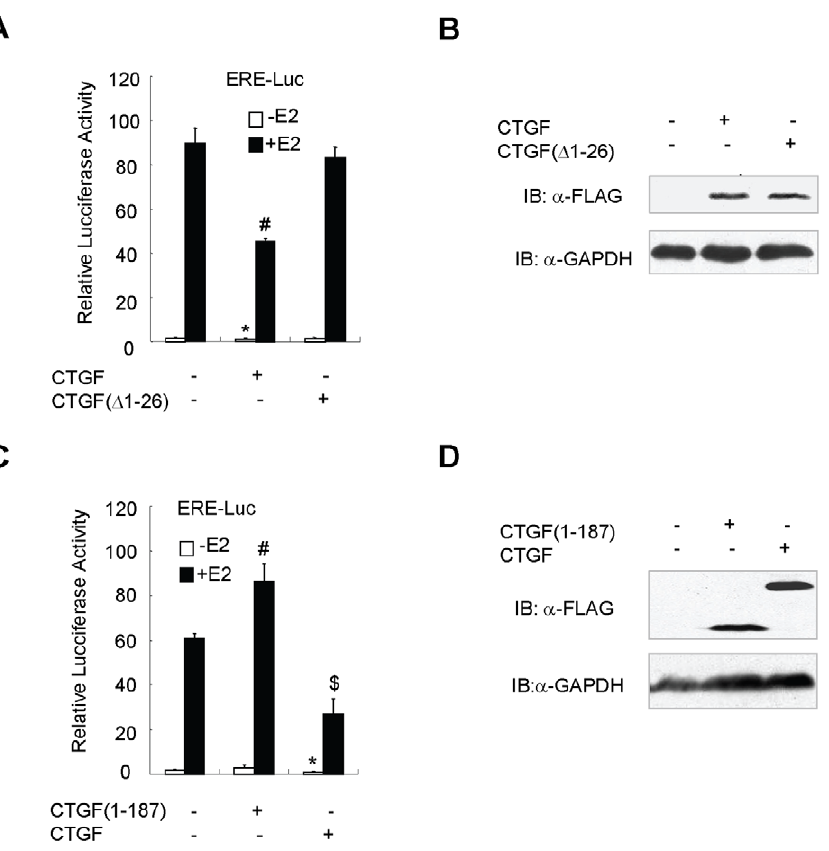
Figure 6. Effects of CTGF deletion mutants on estrogen-responsive reporter activity. (A) Luciferase reporter assay with the CTGF deletion mutant without the signal peptide. ZR75-1 cells were cotransfected with ERE-Luc and FLAG-tagged CTGF or CTGF( D 1-26) as indicated. Cells were treated and analyzed as in Fig. 4A. * P , 0.01 versus empty vector without E2. # P , 0.01 versus empty vector with E2. (B) Western blotting showing expression levels of FLAG-tagged CTGF and CTGF( D 1-26) with antibody against FLAG or GAPDH. Cells were transfected in the presence of E2 as in (A). (C) Luciferase reporter assay with the CTGF deletion mutant lacking ER-binding site. Cells were cotransfected with ERE-Luc and FLAG-tagged CTGF or CTGF(1–187) as indicated. * P , 0.01 versus empty vector without E2. # P , 0.05 versus empty vector with E2. $ P , 0.01 versus empty vector with E2. (D) Western blotting showing expression levels of FLAG-tagged CTGF and CTGF(1–187) with antibody against FLAG or GAPDH. Cells were transfected in the presence of E2 as in (C). Conditioned medium was used for Western blotting analysis of the expression of FLAG-tagged CTGF and CTGF(1–187), and the whole cell lysate was used for Western blotting analysis of the expression of GAPDH.